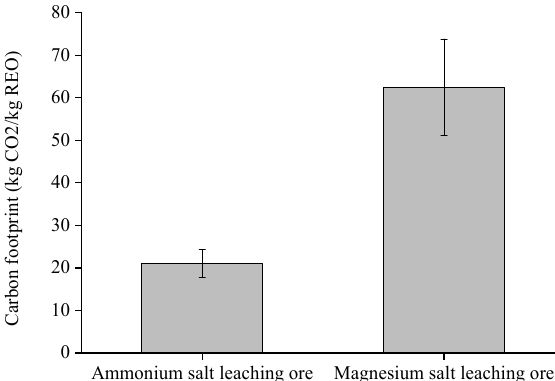
Figure 6. Impact of technological transformation on carbon footprint.